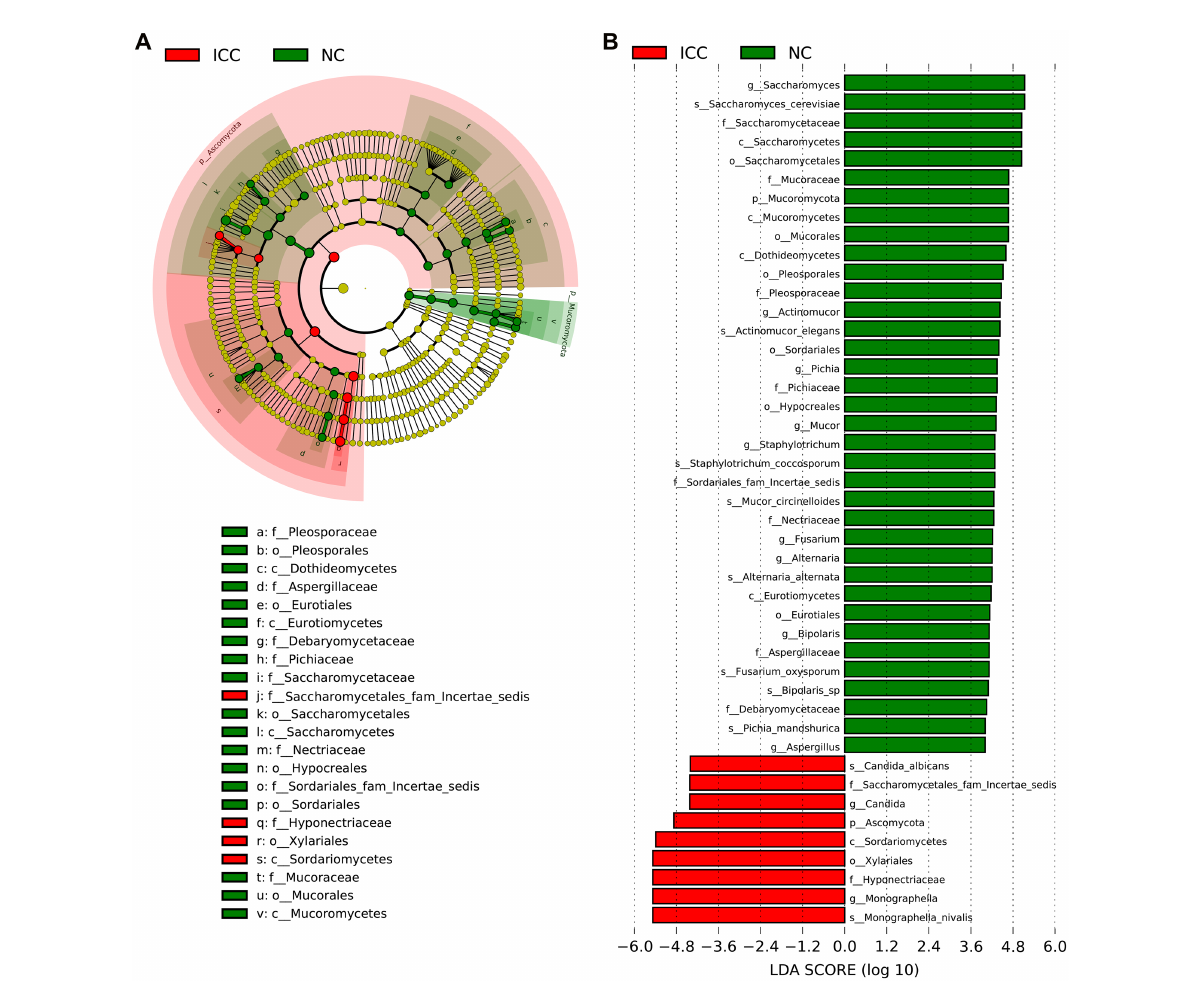
FIGURE 3 The differential taxa in the ICC and NC groups using the linear discriminant analysis effect size (LEfSe) analysis. (A) Taxonomic cladogram from LEfSe showing differences in fecal taxa of ICC patients and healthy controls. (B) LDA scores were computed for differentially abundant taxa in the gut fungi of ICC patients and healthy controls. Length indicates the effect size associated with a taxon. p = 0.05 for the Kruskal-Wallis sum-rank test; LDA score > 4; NC, healthy controls; ICC, intrahepatic cholangiocarcinoma; LDA, linear discriminant